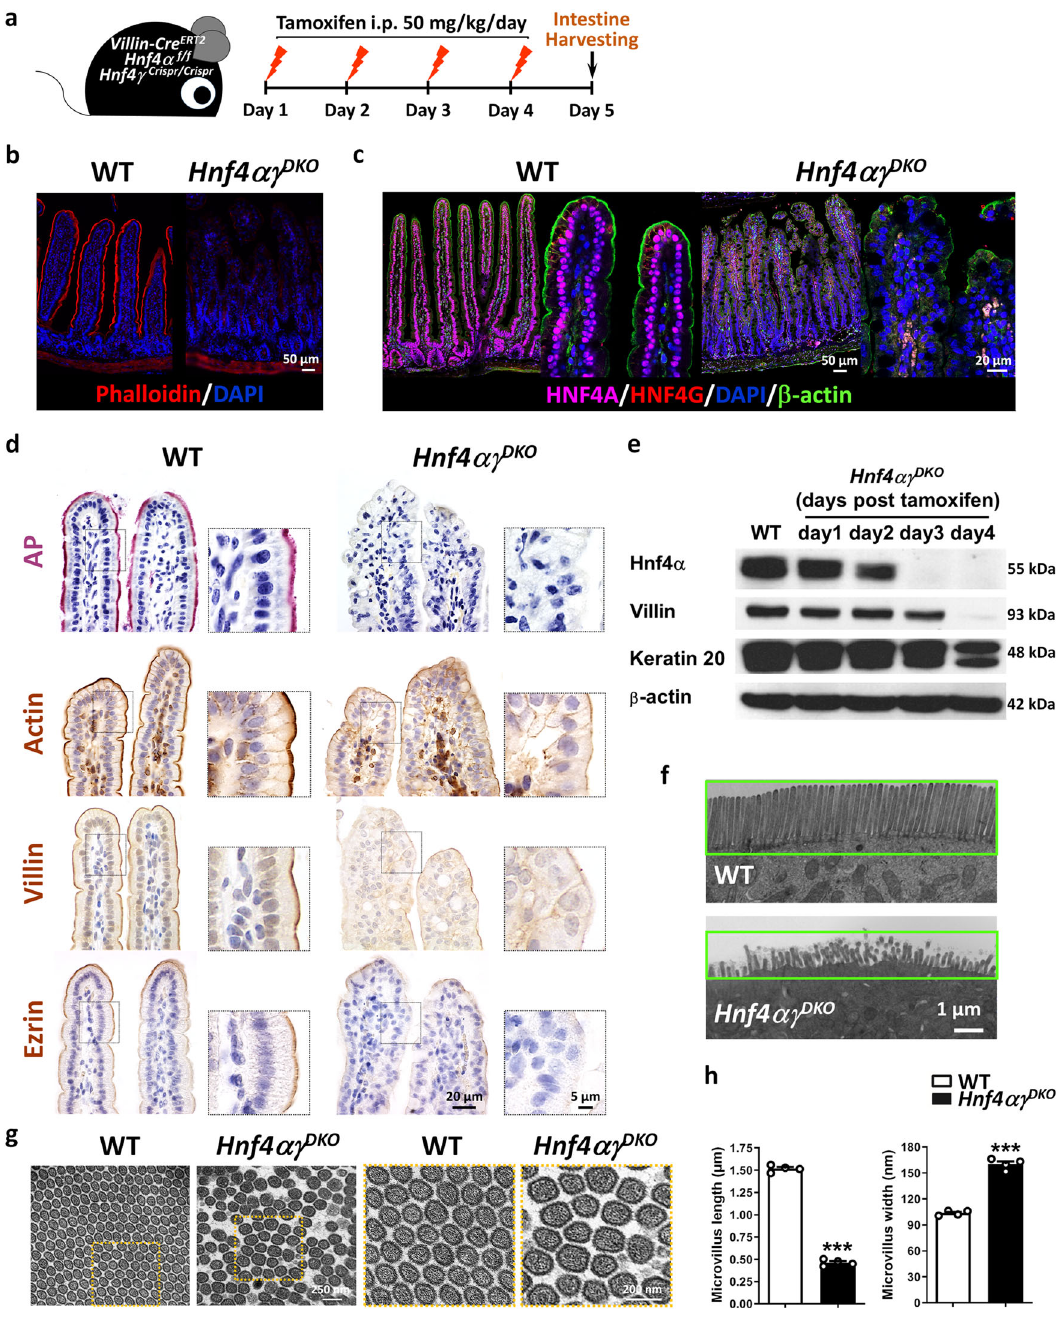
Fig. 3 HNF4 transcription factors are required for intestinal brush border. a Schematic of experimental design. b Phalloidin staining ( n = 3 biologically independent mice). c Co-staining of HNF4A, HNF4G, and β -actin (brush border marker) by immuno fl uorescence confocal microscopy ( n = 3 biologically independent mice). Individual images are shown in Supplementary Fig. 5a. d Brush border markers, such as alkaline phosphatase (AP, pink color), β -actin (brown color), Villin (brown color), and Ezrin (brown color) are localized to the apical surface of villus enterocytes and normally expressed in WT. Compromised expression levels of these brush border markers were observed in Hnf4 αγ DKO mice after 4 days of tamoxifen injection ( n = 3 biologically independent mice). e Brush border markers (e.g., Villin and Keratin 20) were decreased in a time-dependent manner upon HNF4 loss, as evidenced by western blotting ( n = 2 independent experiments). Brush border microvilli were notably shorter and disorganized ( f ) but wider ( g ) in Hnf4 αγ DKO mutants compared to WT mice, as evidenced by electron microscopy ( n = 4 biologically independent mice, 4 days after tamoxifen injection). The high- magni fi cation images are shown in the boxed insets. h Quanti fi cation of microvillus length and width. The data are presented as mean ± SEM ( n = 4 biologically independent mice, Student ’ s t -test, two-sided at *** P < HNF4A is required for embryonic yolk sac brush border . In (Fig. 5a). HNF4A is expressed throughout the yolk sac epithe- addition to intestinal epithelium, the brush border can also be lium, both in the villous tissue proximal to the placental disc and found in murine embryonic yolk sac epithelium 30 . Unlike the in smoother epithelial tissue in more distal areas (Fig. 5b). To intestinal epithelium, Hnf4g is not detectable in the yolk sac study the function of HNF4 in the embryonic yolk sac, we crossed